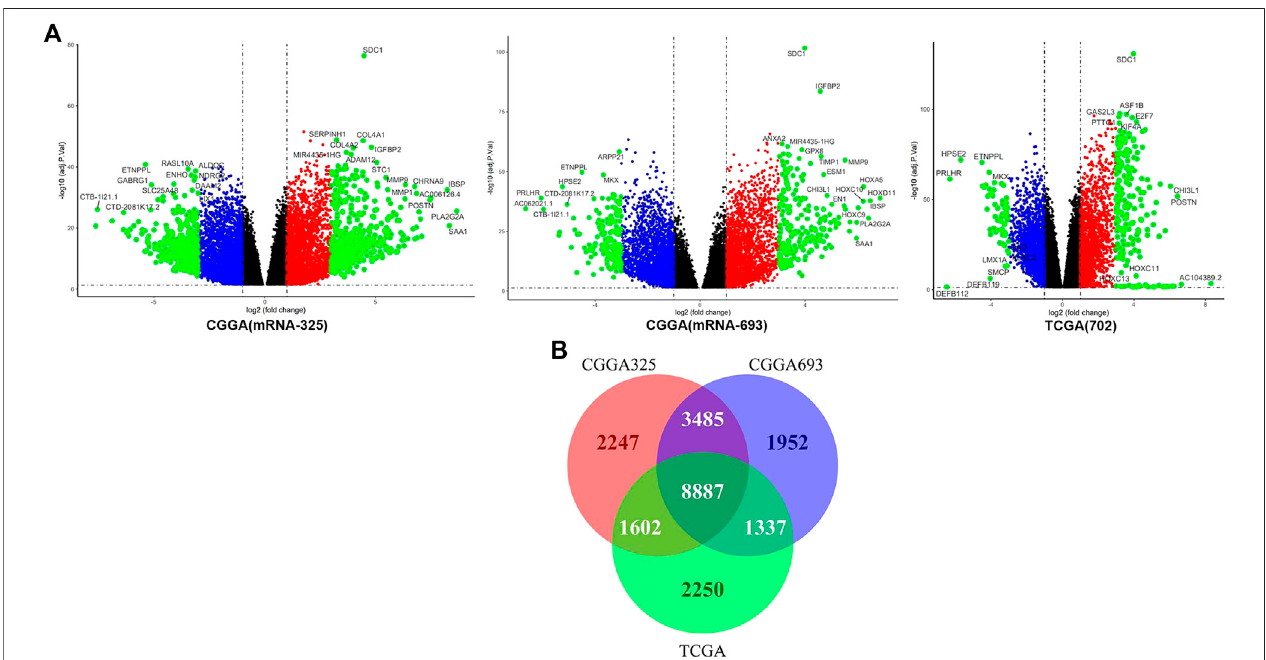
FIGURE4|(A) Thevolcanomapsdisplay thedifferentialgenes. (B) TheVenndiagrams revealthecoexistinggenesinthethreedifferentgenesets;there are8,887 genes in the coexist